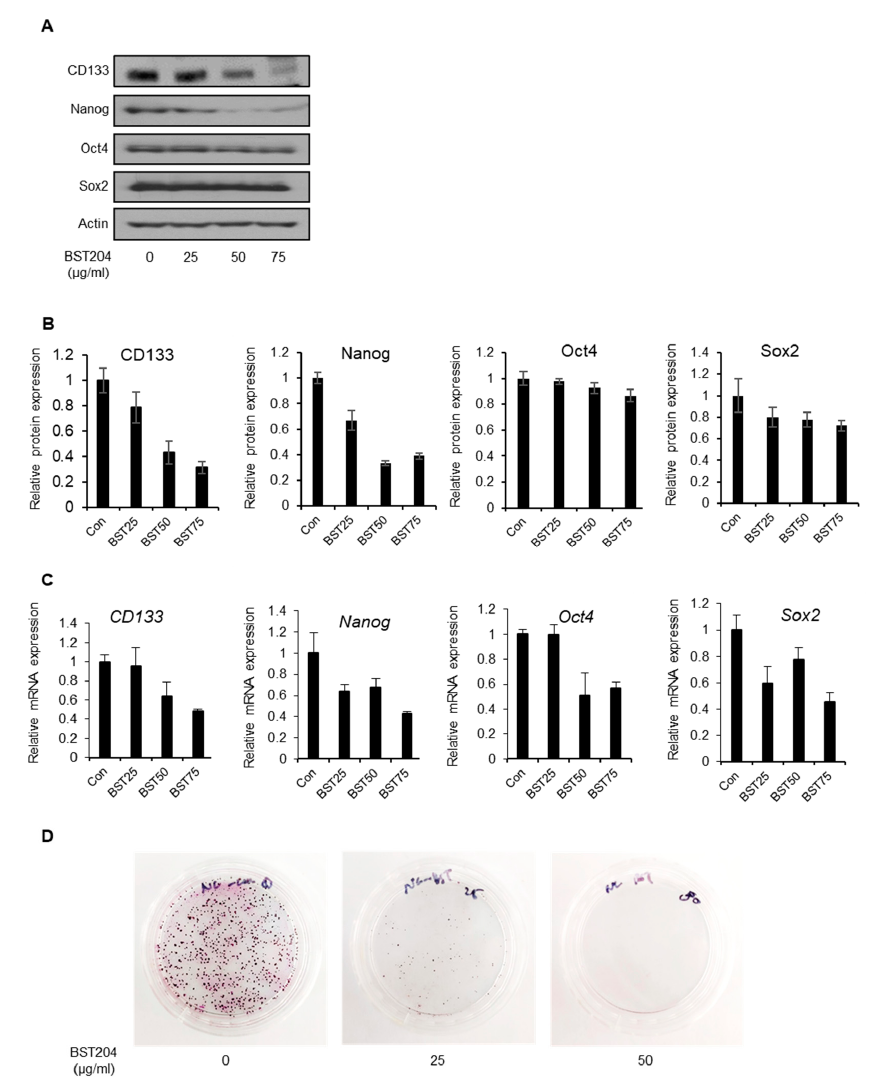
Figure 2. Effect of BST204 on cancer stemness gene expression and tumorigenesis. ( A ) Expression of CD133, Nanog, Oct4, and Sox2 was analyzed by immunoblotting. Actin was used as an internal control. ( B ) Relative expression of each protein was analyzed. ( C ) The mRNA levels of CD133, Nanog, Oct4, and Sox2 were analyzed by RT-qPCR. ( D ) In the colony formation assay, NCCIT cells were seeded in plates and incubated with BST204 until the formation of colonies. The colonies were stained with 0.5% crystal